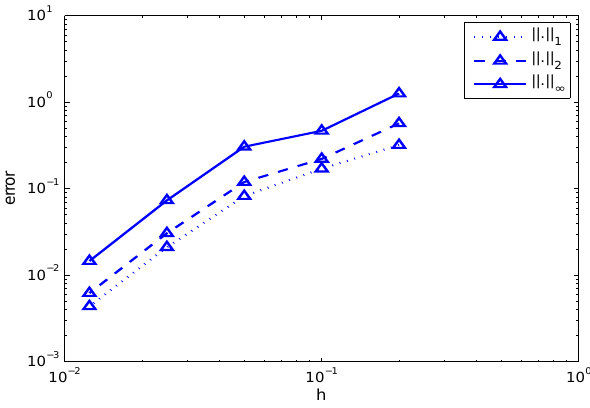
Figure 7. Error for the approximate solution p ( v , t ) plotted in Figure